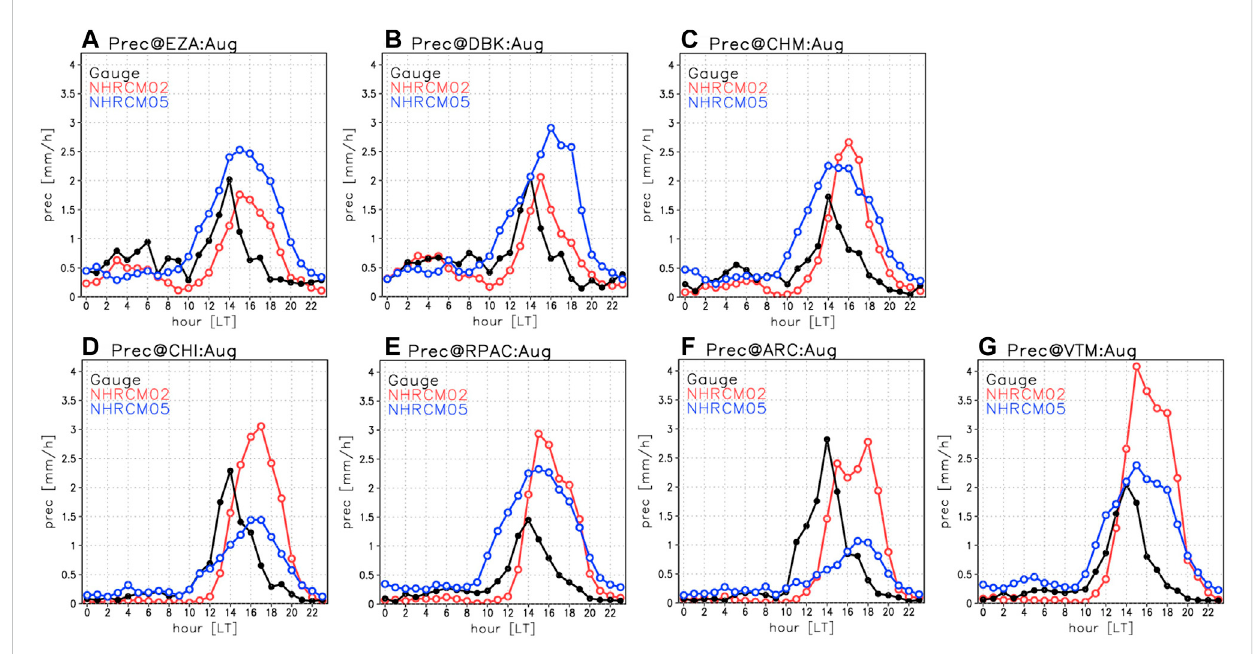
FIGURE 3 Climatological diurnal change of precipitation in August. The black line indicates the observation, and the red (blue) line is derived from NHRCM02